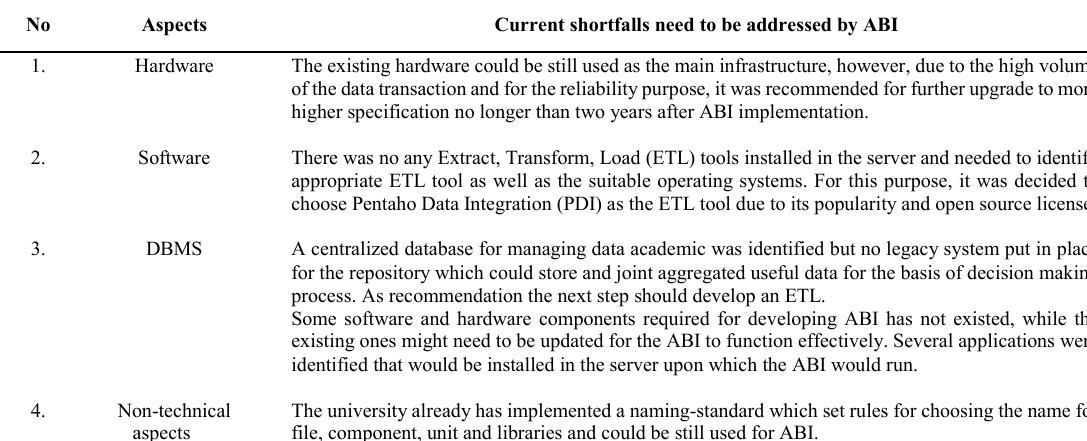
TABLE 2 R ESULTS FROM THE EXISTING INFRASTRUCTURE